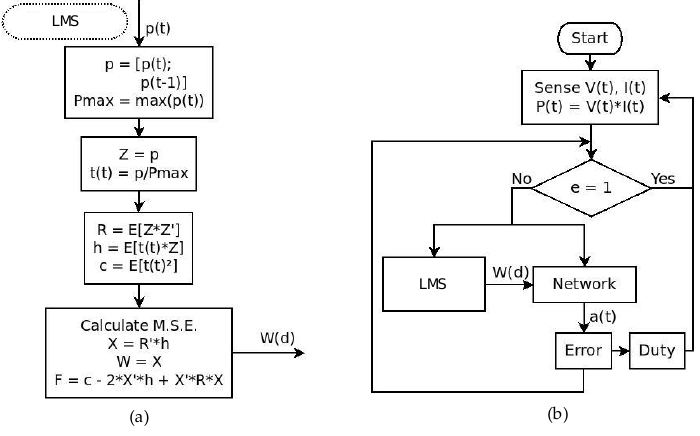
Figure 7. Flow diagrams: ( a ) LMS Algorithm; ( b ) LMS Controller.